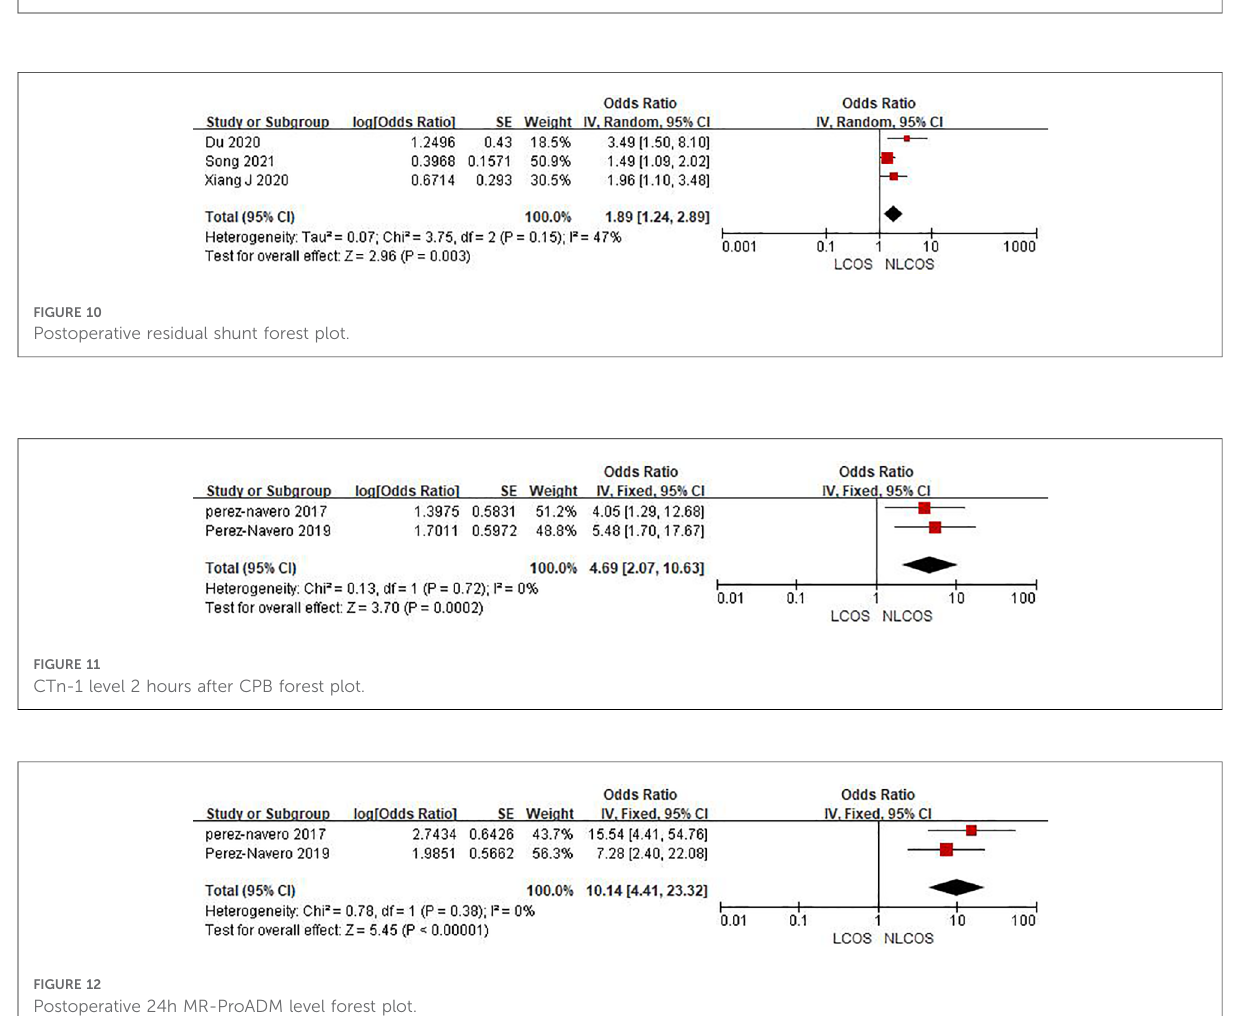
FIGURE 9 ACC duration forest plot.